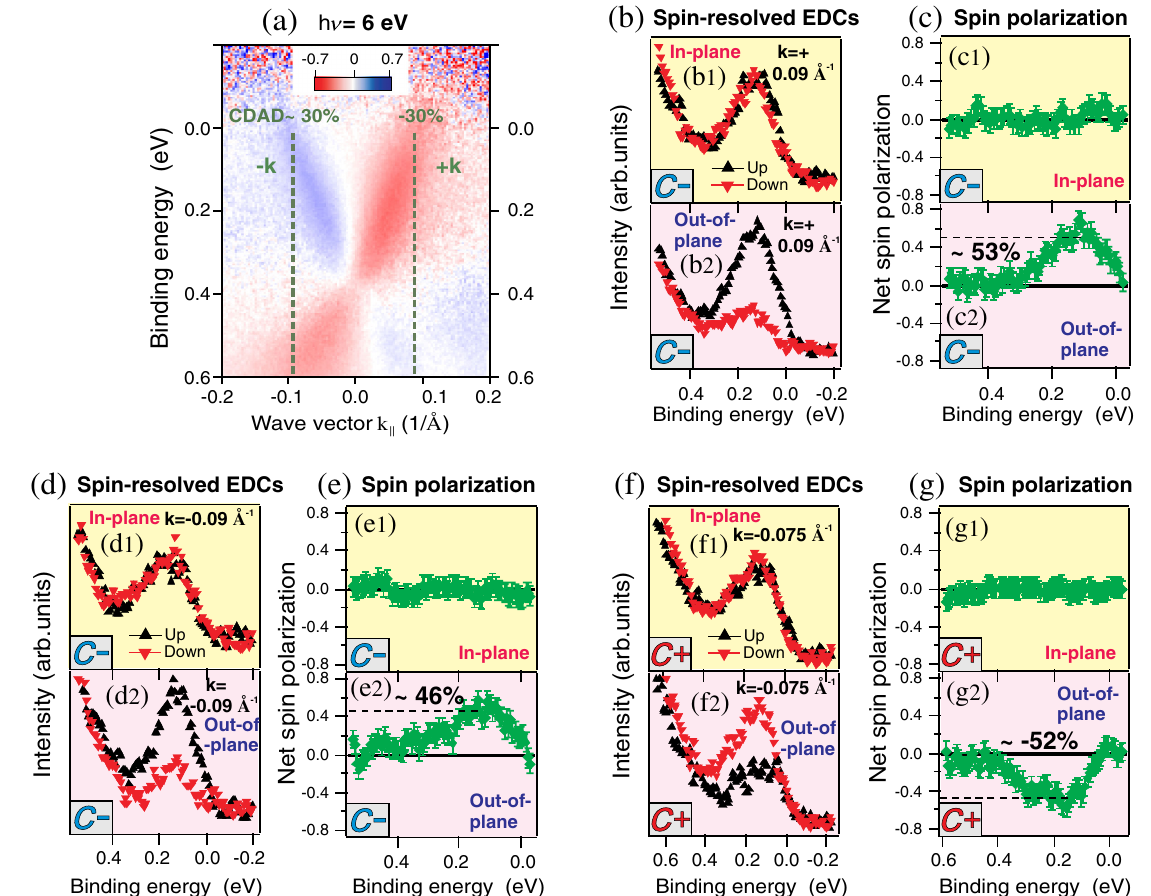
FIG. 3. Out-of-plane switching of the spin texture from the TSS observed upon reversal of the circular light polarization at 6-eV photon energy. (a) k -resolved CDAD asymmetry. The dashed green lines mark the k ∥ wave vectors of the SR-ARPES measurements. (b),(d),(f) In-plane [(b1),(d1),(f1)] and out-of-plane [(b2),(d2),(f2)] spin-resolved EDCs. (c),(e),(g) Corresponding net spin polar- izations. The out-of-plane spin polarization (zero in plane) does not reverse when going from þ k ∥ to − k ∥ wave vectors and switches with the light helicity. Spectra are acquired using geometry II as well as (b) – (e) circular negative ( C − ) and (f),(g) circular positive ( C þ ) light